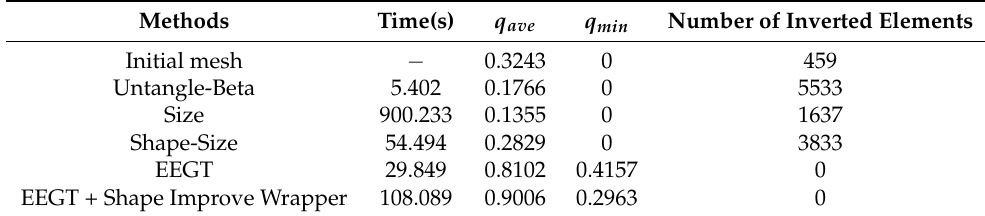
Table 2. Mesh quality statistics and the number of inverted elements for mesh deformation example. The mean ratio quality metric is used to measure the mesh